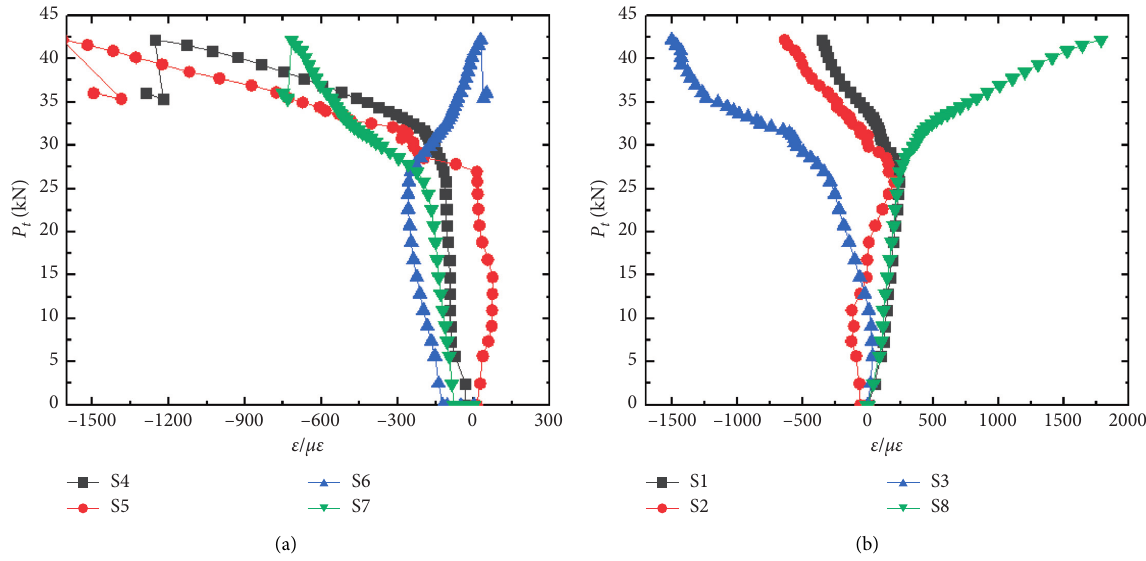
Figure 13: Load and strain curves for specimen C9008-03-CH31. (a) Midheight. (b) About 50mm higher than